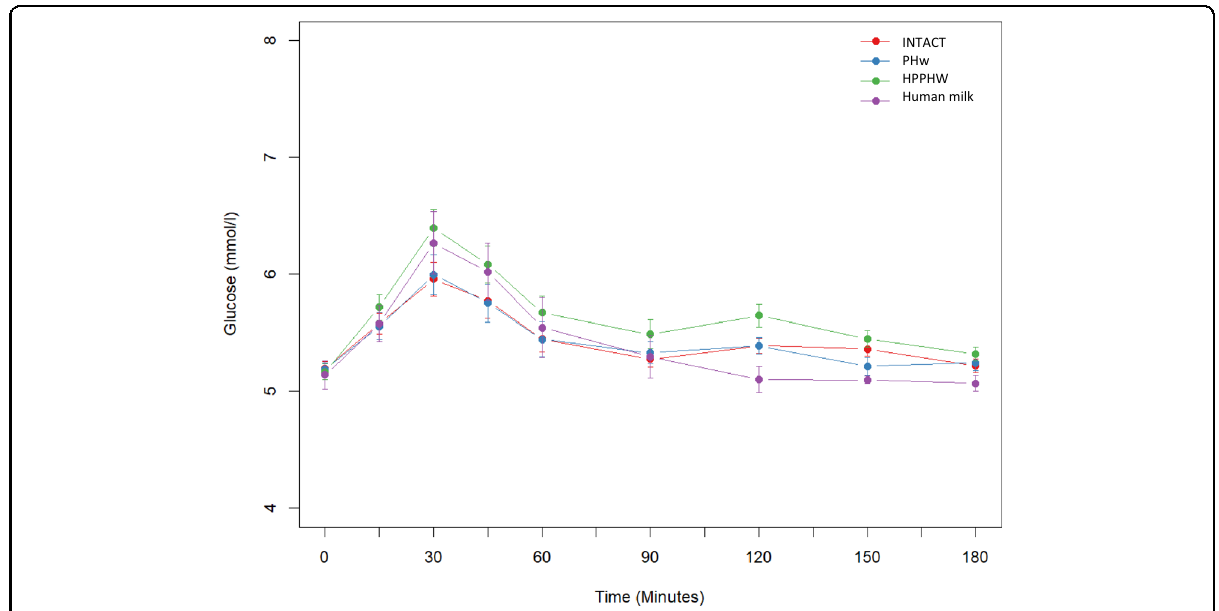
Fig. 3 Glucose response to infant formulas and human milk overtime in healthy subjects from baseline and every 30 min for 180 mins post-ingestion. Red: INTACT ( n = 29), intact protein formula; Blue: PHw ( n = 29), partially hydrolyzed whey protein formula; Green: HPPHW ( n = 28), higher protein PHw formula; Violet: Human milk ( n = 8). Data are mean ±